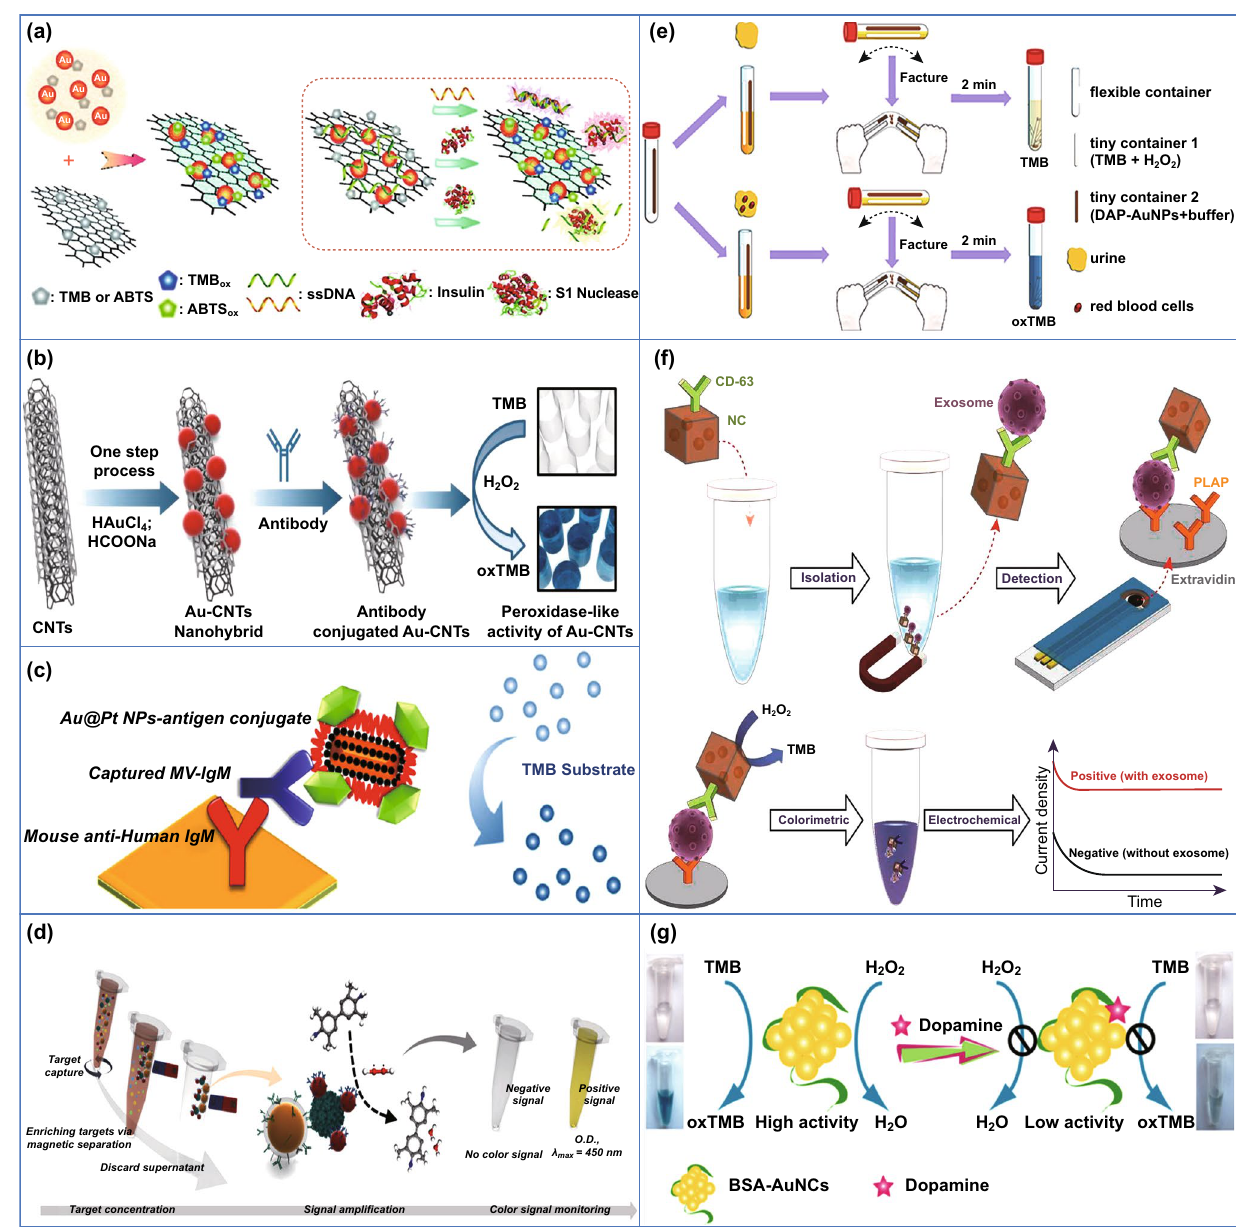
Fig. 7 Peroxidase‑like activity of AuNPs used as clinical diagnostic tools. a AuNPs grown on graphene sheets used to develop a “off–on” colourimetric sensor [134]. Copyright 2012 American Chemical Society. b Nanohybrid composed of AuNPs and CNTs acting as colourimet‑ ric influenza virus detection [131]. Copyright 2016 Elsevier B.V. c Rod‑shaped Au–Pt core/shell NPs used for measles virus detection [129]. Copyright 2018 Long et al. d Magnetic nanobeads combined with AuNPs for separation and detection of influenza virus [130]. Copyright 2018 American Chemical Society. e User‑friendly device for haemoglobin and red blood cells detection in urine samples [127]. Copyright 2018 Else‑ vier B.V. f Gold‑loaded nanoporous ferric oxide NPs used for direct exosome detection [133]. Copyright 2019 American Chemical Society. g Fluorometric and colourimetric detection of dopamine based on AuNCs [141]. Copyright 2012 Elsevier